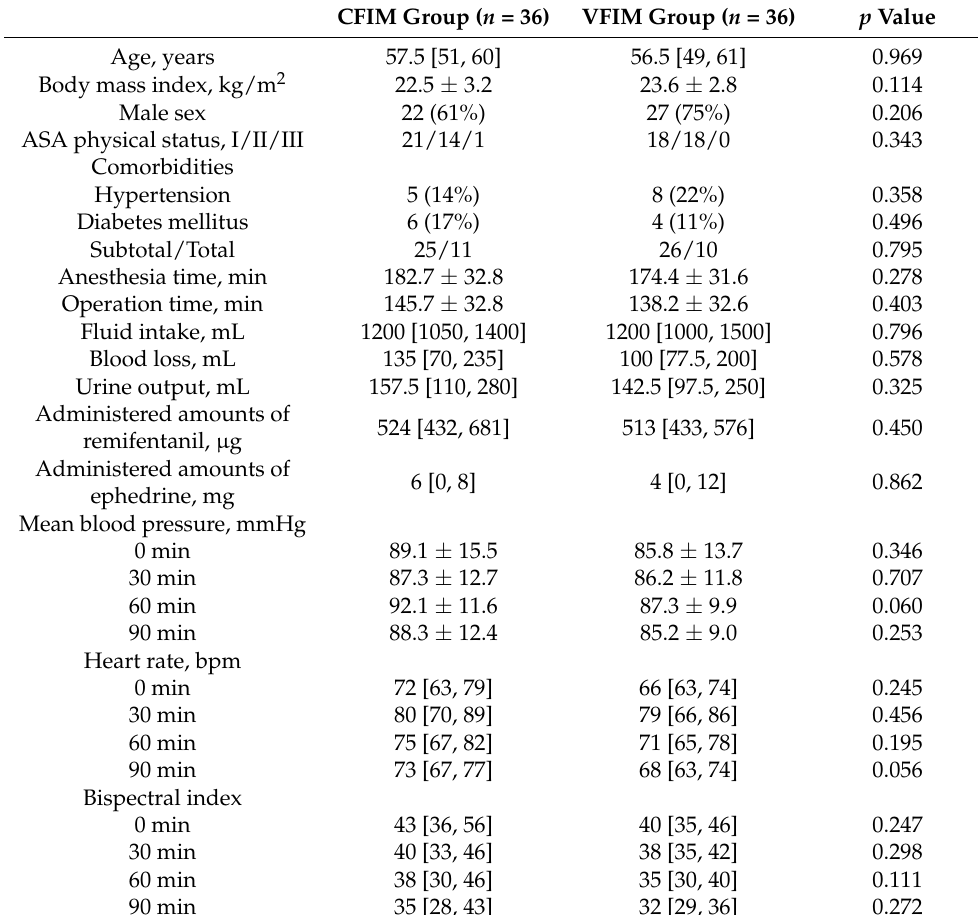
Table 1. Demographic and intraoperative variables.